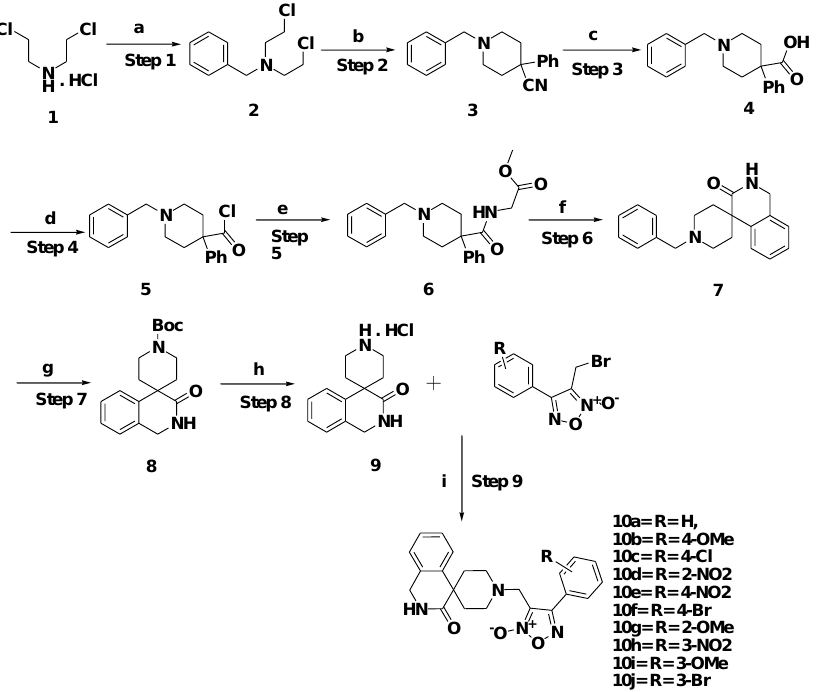
Table 1. Biological activity results.